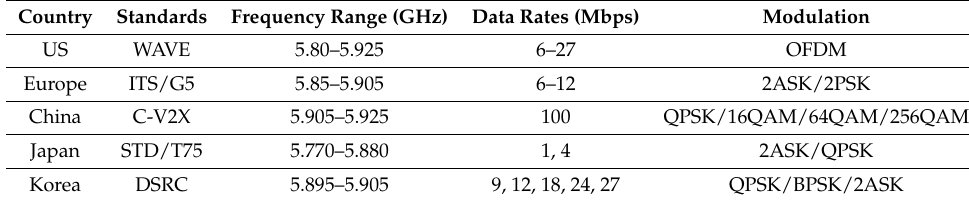
Table 1. Vehicular communication